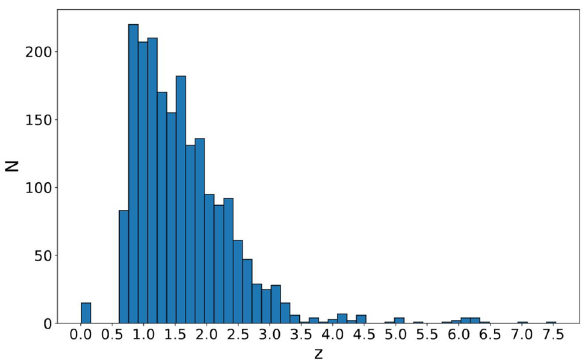
Fig. 1 The redshift distribution of the quasar sample redshift range z < 0 . 7 as the full quasar sample. We show the redshift distribution of the full quasar sample in Fig.